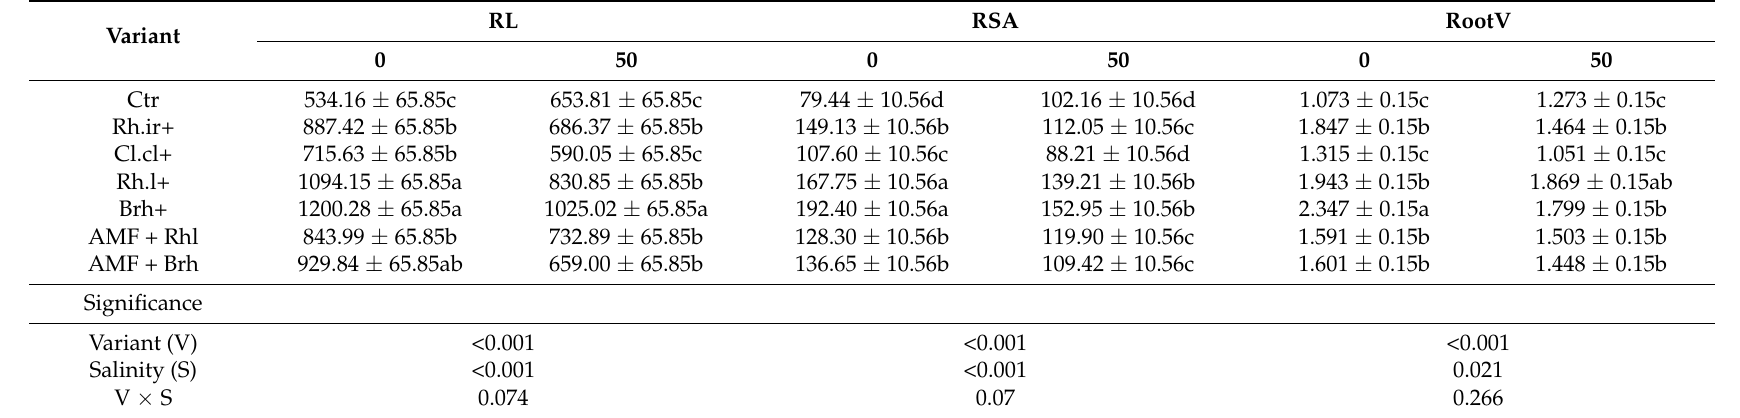
Table 1. Root length (RL, cm), root surface area (RSA, cm 2 ) and root volume (RootV, cm 3 ) of control (Ctr), Rhizophagus irregularis —inoculated (Rh.ir+), Claroideoglomus claroideum —inoculated (Cl.cl+), Rhizobium leguminosarum —inoculated (Rh.l+), Burkholderia spp.—inoculated (Brh+), Rhizophagus irregularis + Claroideoglomus claroideum + Rhizobium leguminosarum —inoculated (AMF + Rhl), and Rhizophagus irregularis + Claroideoglomus claroideum + Burkholderia spp.—inoculated (AMF + Brh) pea plants under two levels of salinity (0 and 50 mM NaCl). Different letters indicate significant differences within following parameters (Tukey test, p < 0.05; mean ±